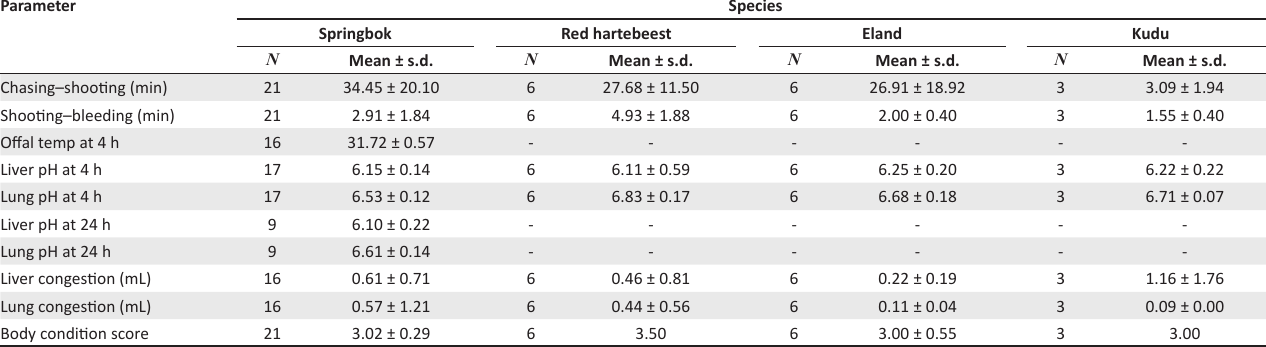
TABLE 3: Descriptive statistical values of the measured baseline variables and parameters of the four game species studied. Parameter